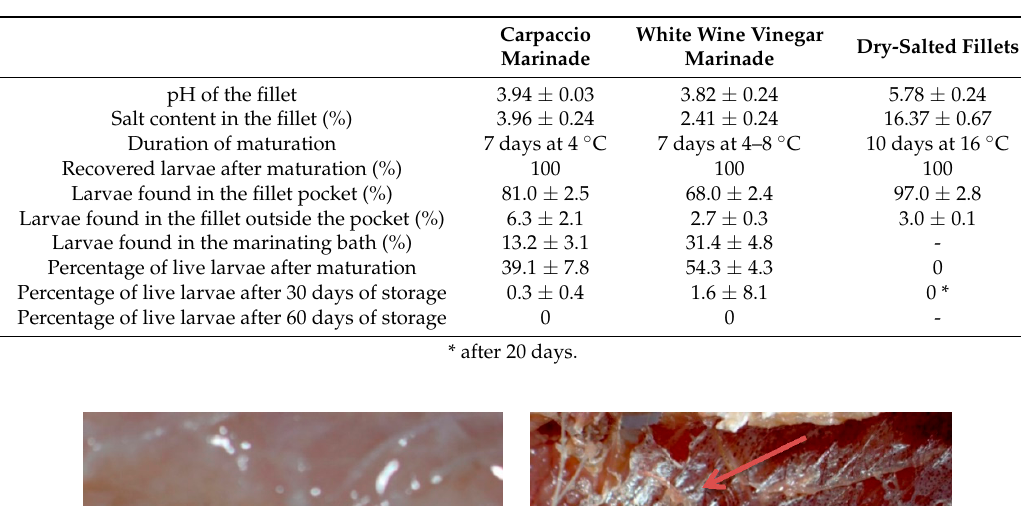
Table 1. Chemical characteristics and viability of Anisakis spp. larvae during the marinating processes (carpaccio and white vinegar/salt) and dry salting of anchovy.